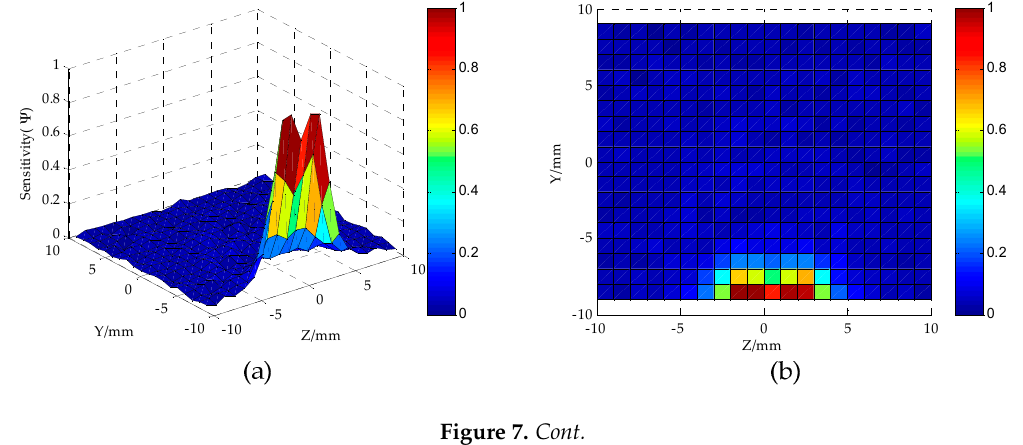
Figure 7. Cont. Figure 7.